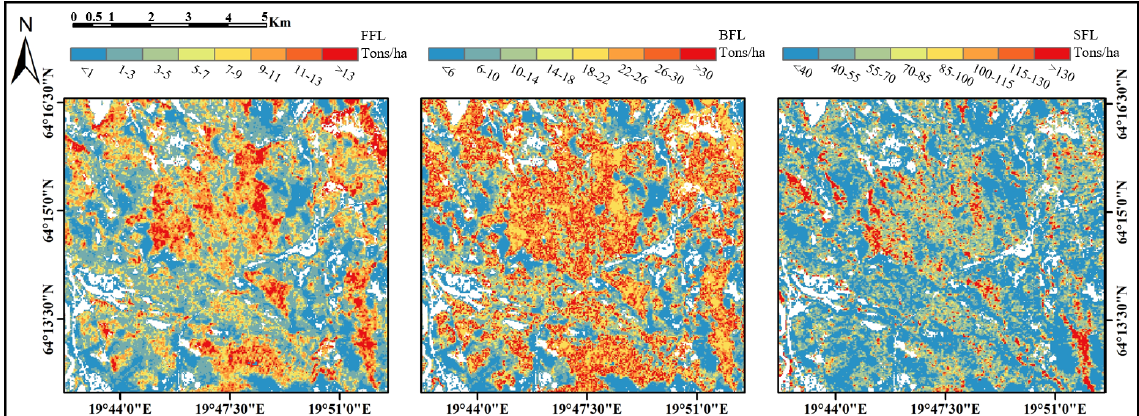
Figure 4. The spatial distribution of FL AGL in the study area.